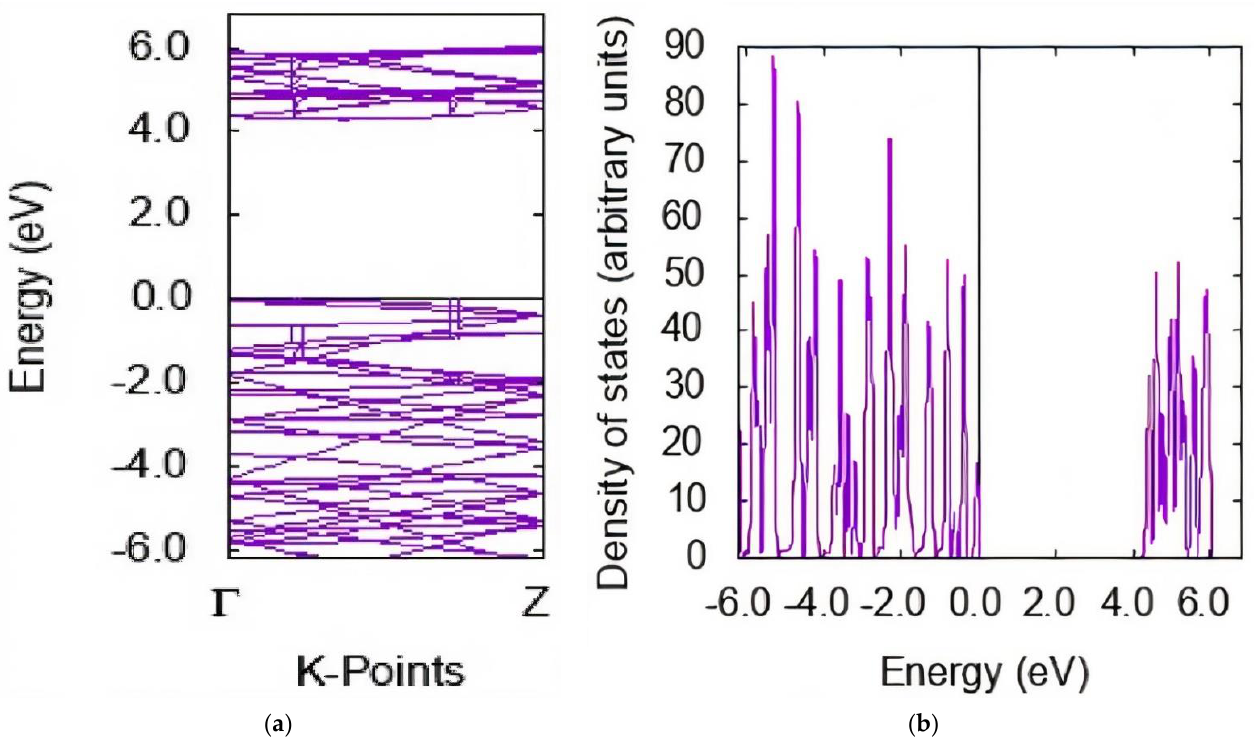
Figure 2. Electronic plots for ( a ) band structure of pristine (5,5) BNNT, and ( b ) DOS of pristine (5,5) BNNT.